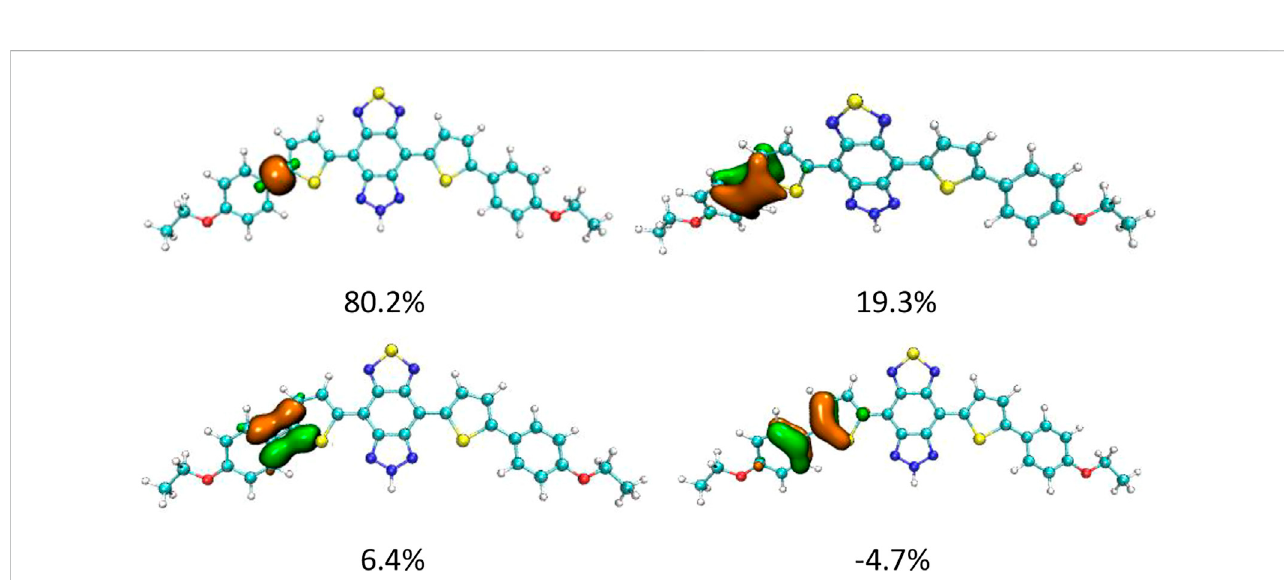
FIGURE 4 NAdO distribution of the a -related C – C bonds in DAD-TZ.